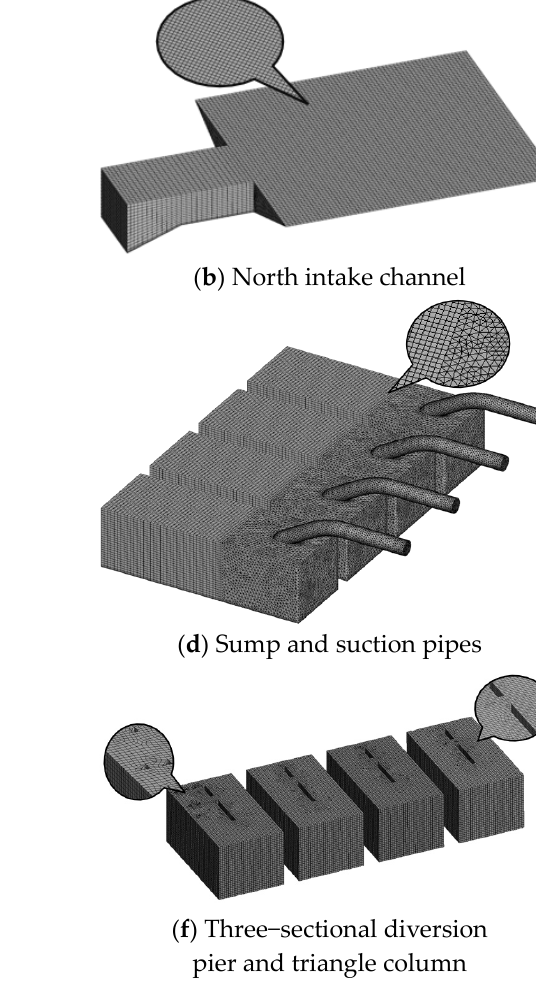
Figure 3. Mesh Preparation.